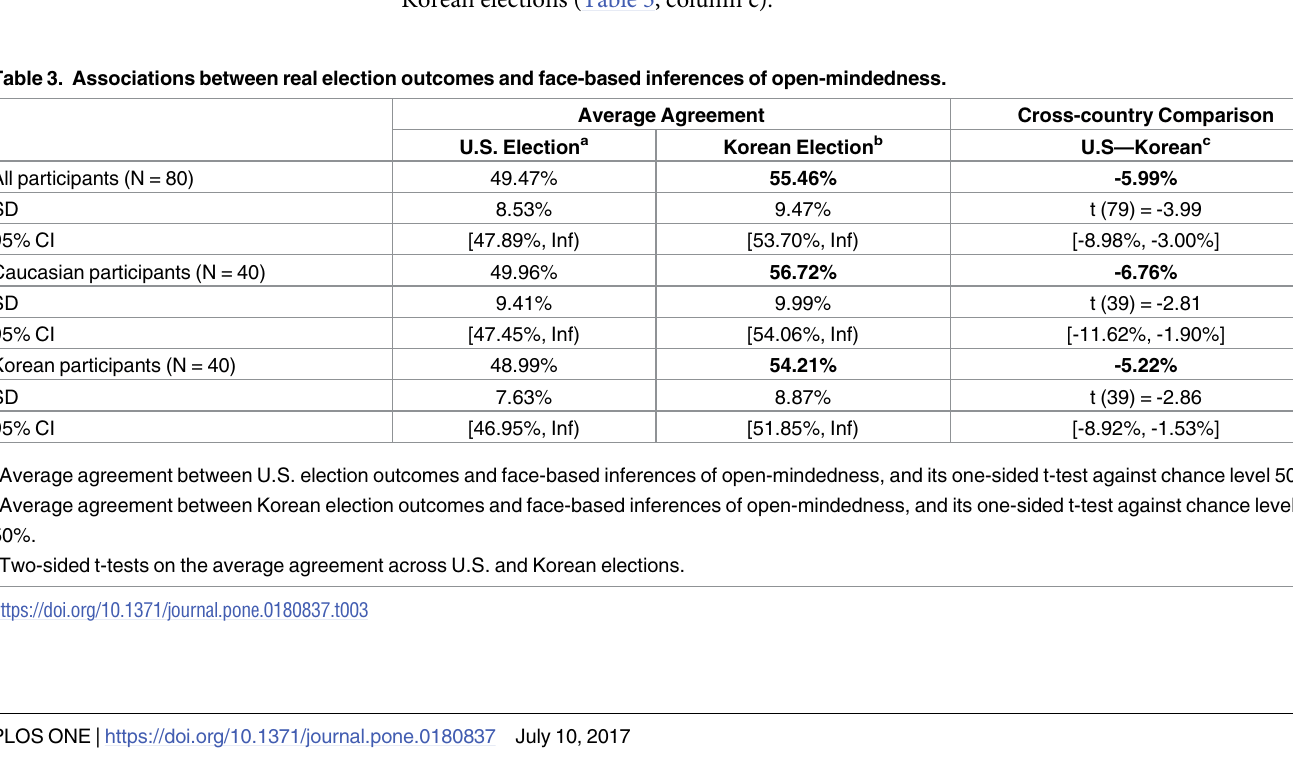
correlated with Korean election outcomes more strongly than U.S. election outcomes (Table 3,